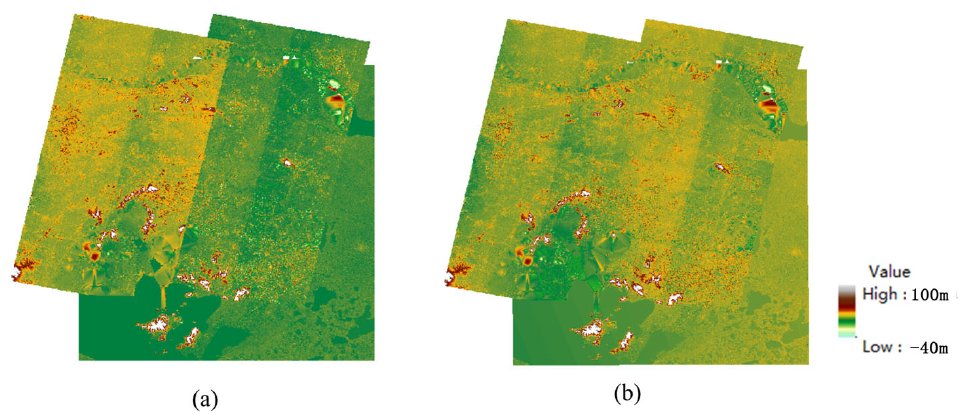
Figure 6. DSM comparison before and after the block adjustment for SRTM and ZY-3 DSM. ( a ) Before block adjustment, and ( b ) after block adjustment.